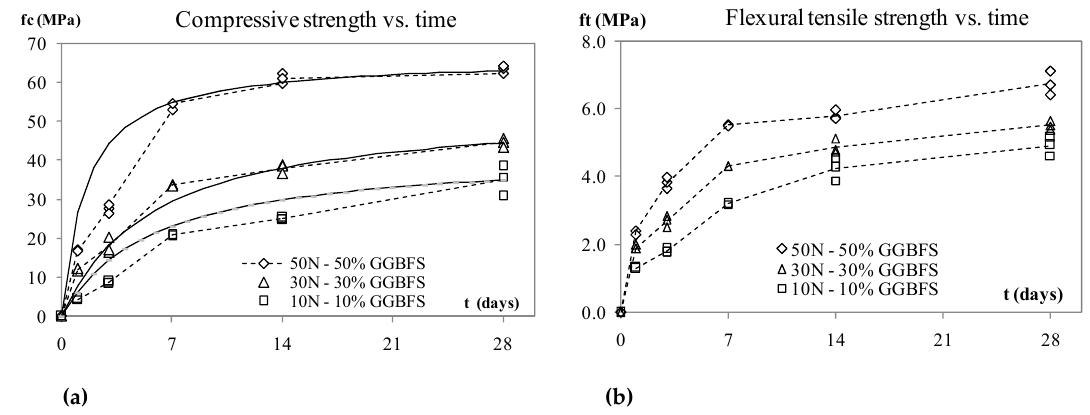
Figure 3. ( a ): Evolution of compressive strength as a function of curing time and comparison with EUROCODE ( b ): Evolution of flexural tensile strength as a function of curing time.